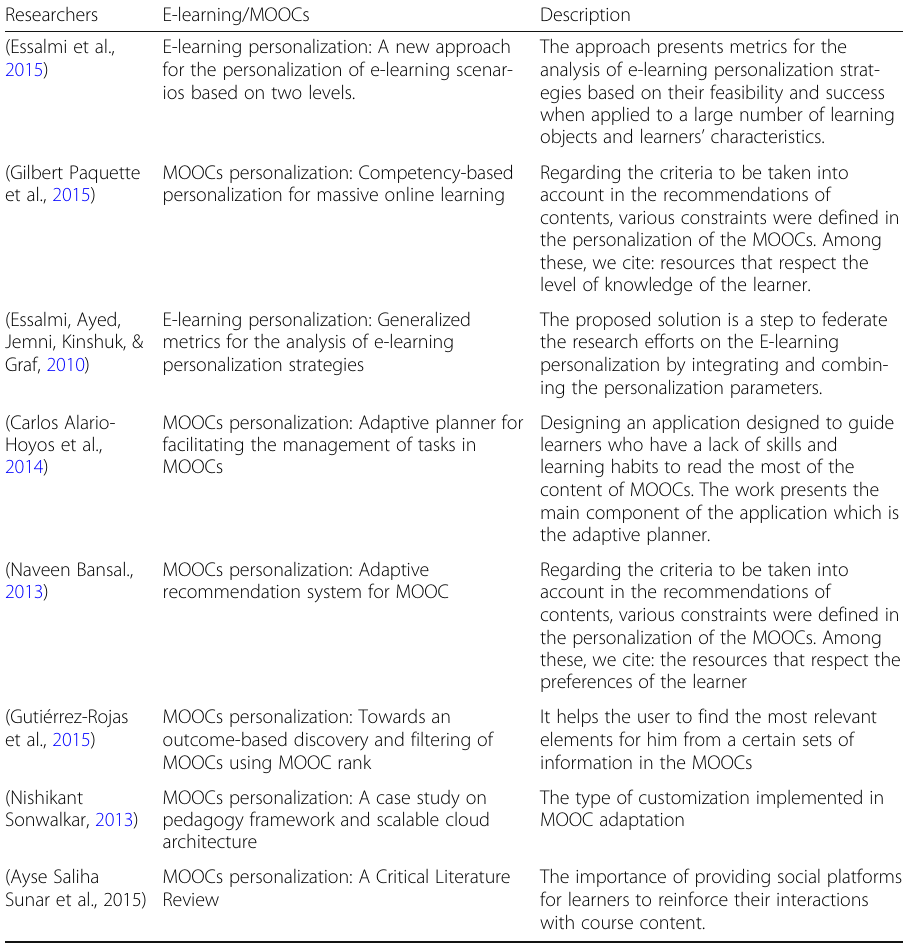
Table 1 Examples of personalization approaches for the E-learning and MOOCs